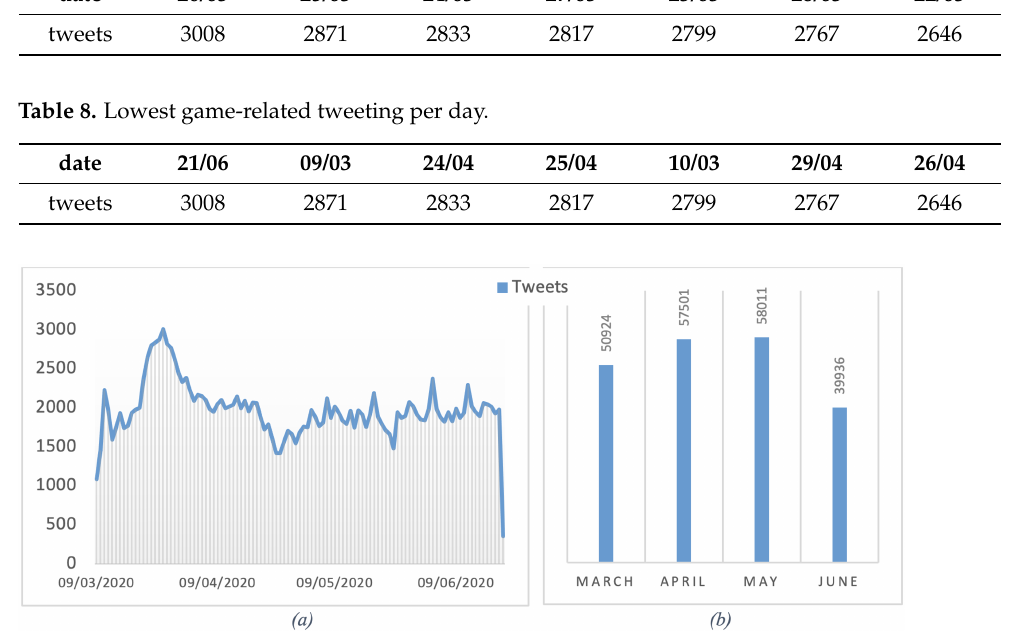
Figure 3. Game-related tweets. ( a ) Tweeting trends sorted by day. ( b ) Tweeting trends sorted by